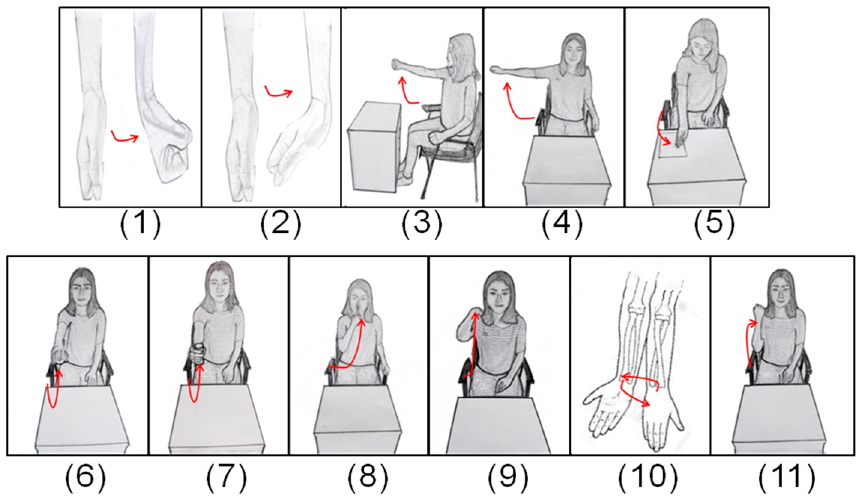
Figure 2. Sketch map of the canonical tasks (taking the right upper limb as an example): ( 1 ) wrist flexion; ( 2 ) wrist extension; ( 3 ) shoulder flexion to 90°, elbow at 0°; ( 4 ) shoulder abduction to 90°, elbow at 0° and forearm pronated; ( 5 ) flip a piece of paper; ( 6 ) fetch and hold a ball put on the table initially and keep shoulder flexion to 90°, elbow at 0°and palm down; ( 7 ) fetch and hold a cylindrical roll put on the table initially and keep shoulder flexion to 90°, elbow at 0°and palm towards the body; ( 8 ) finger to nose; ( 9 ) touch the back of the shoulder ; ( 10 ) keep shoulder at 0°, elbow at 90°and palm down, then do supination/pronation of the forearm for twice; ( 11 ) flex elbow three times as fast as possible.